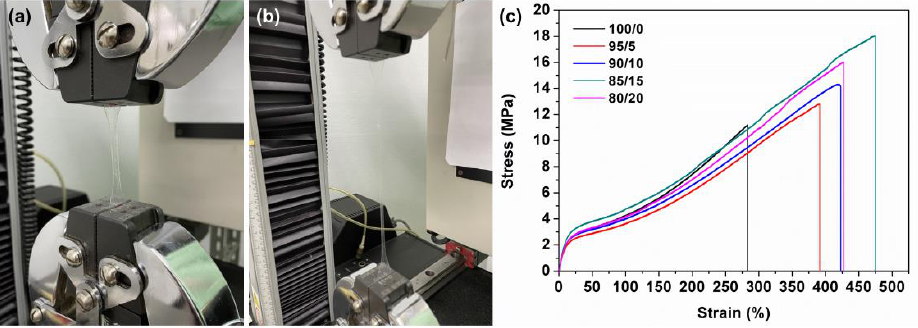
Figure 3. ( a , b ) Tensile test process and ( c ) tensile properties of TPU planks.